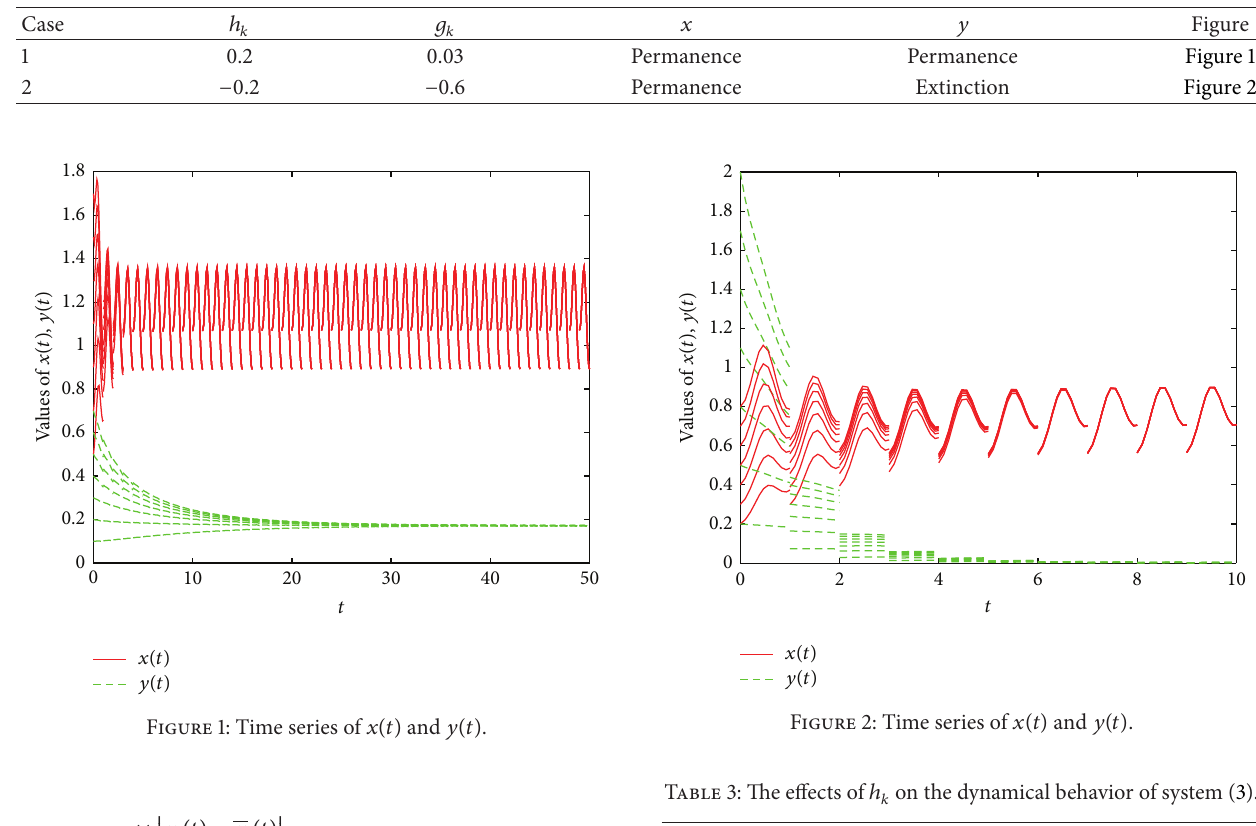
Table 2: The effects of ℎ 𝑘 and 𝑔 𝑘 on the dynamical behavior of system (3).